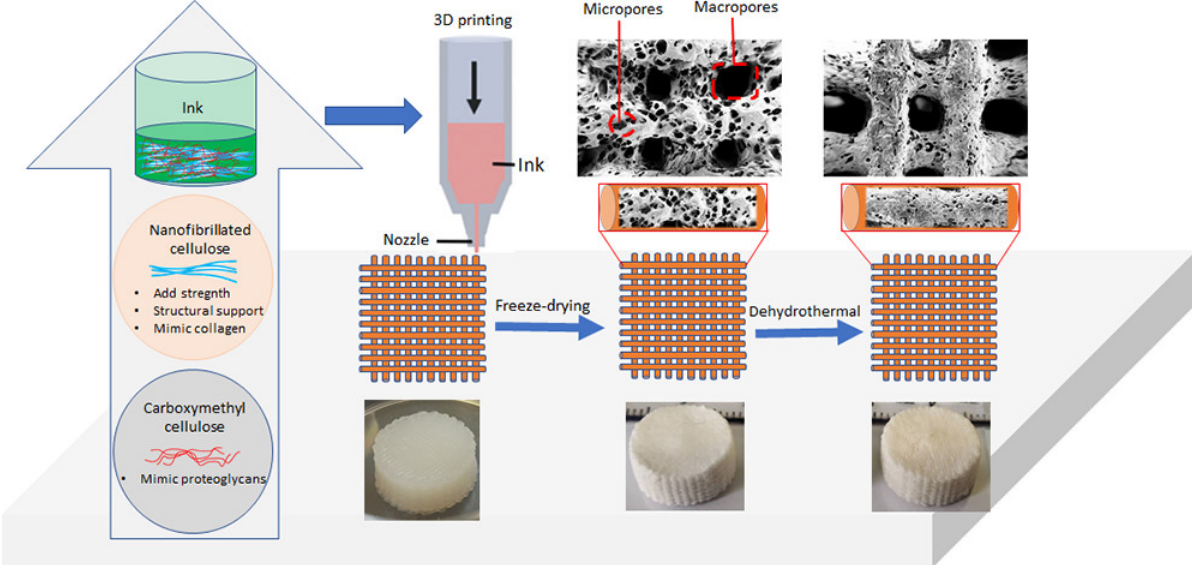
Figure 6. Development of self-standing and lightweight 3D bioscaffolds with microporous and interconnect microporous morphology from bicomponent ink containing NFC and CMC [102], Further permission related to the material excerpted should be directed to the ACS (https://pubs.acs.org/doi/full/10.1021/acsabm.9b01099 (accessed on 8 May 2021)).